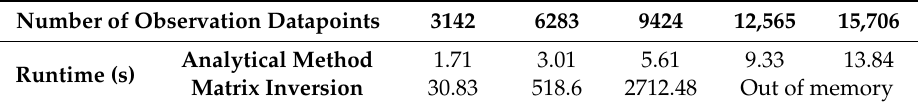
Table 1. Comparison of the runtime of the analytical solution and inverse matrix approach.